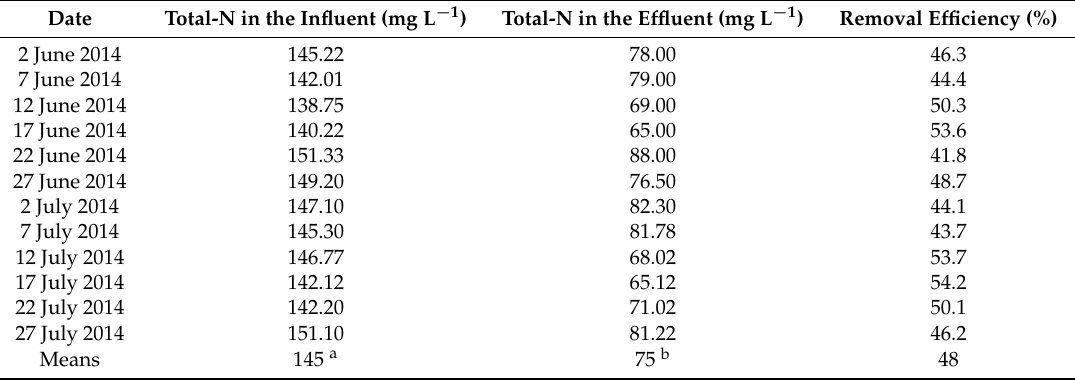
Table 3. Efficiency of a trickling filter in removing total nitrogen from an anaerobic digester